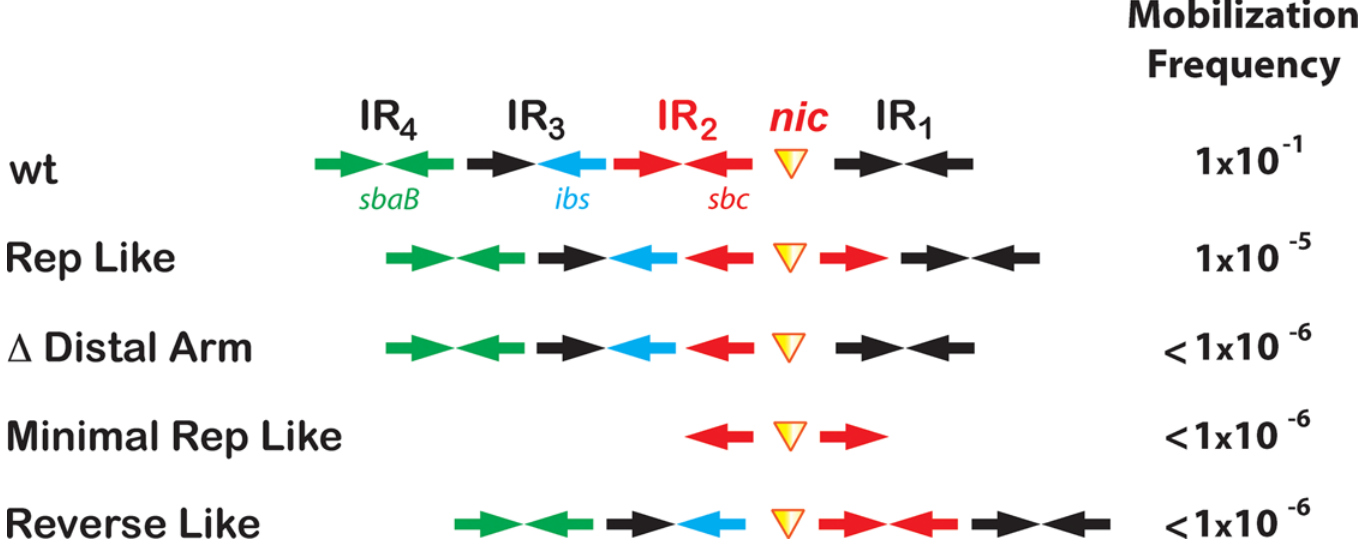
Fig 5. Mobilization frequencies of synthetic ori T-plasmids. Mobilization frequencies obtained using pSU2007 as helper plasmid are expressed as number of transconjugants per donor cell. Values are the average of three experiments. The relative position of the secondary structure elements of the assayed synthetic oriT s is shown. R388 wt oriT has four IR that are binding sites for the relaxase and nicking-accessory proteins TrwA and IHF. TrwC binds IR 2 and the nic site ( sbc , red), TrwA binds IR 4 ( sbaB , green) while IHF binds IR 3 ( ibs , blue). The distance between secondary structure elements is not shown at scale.